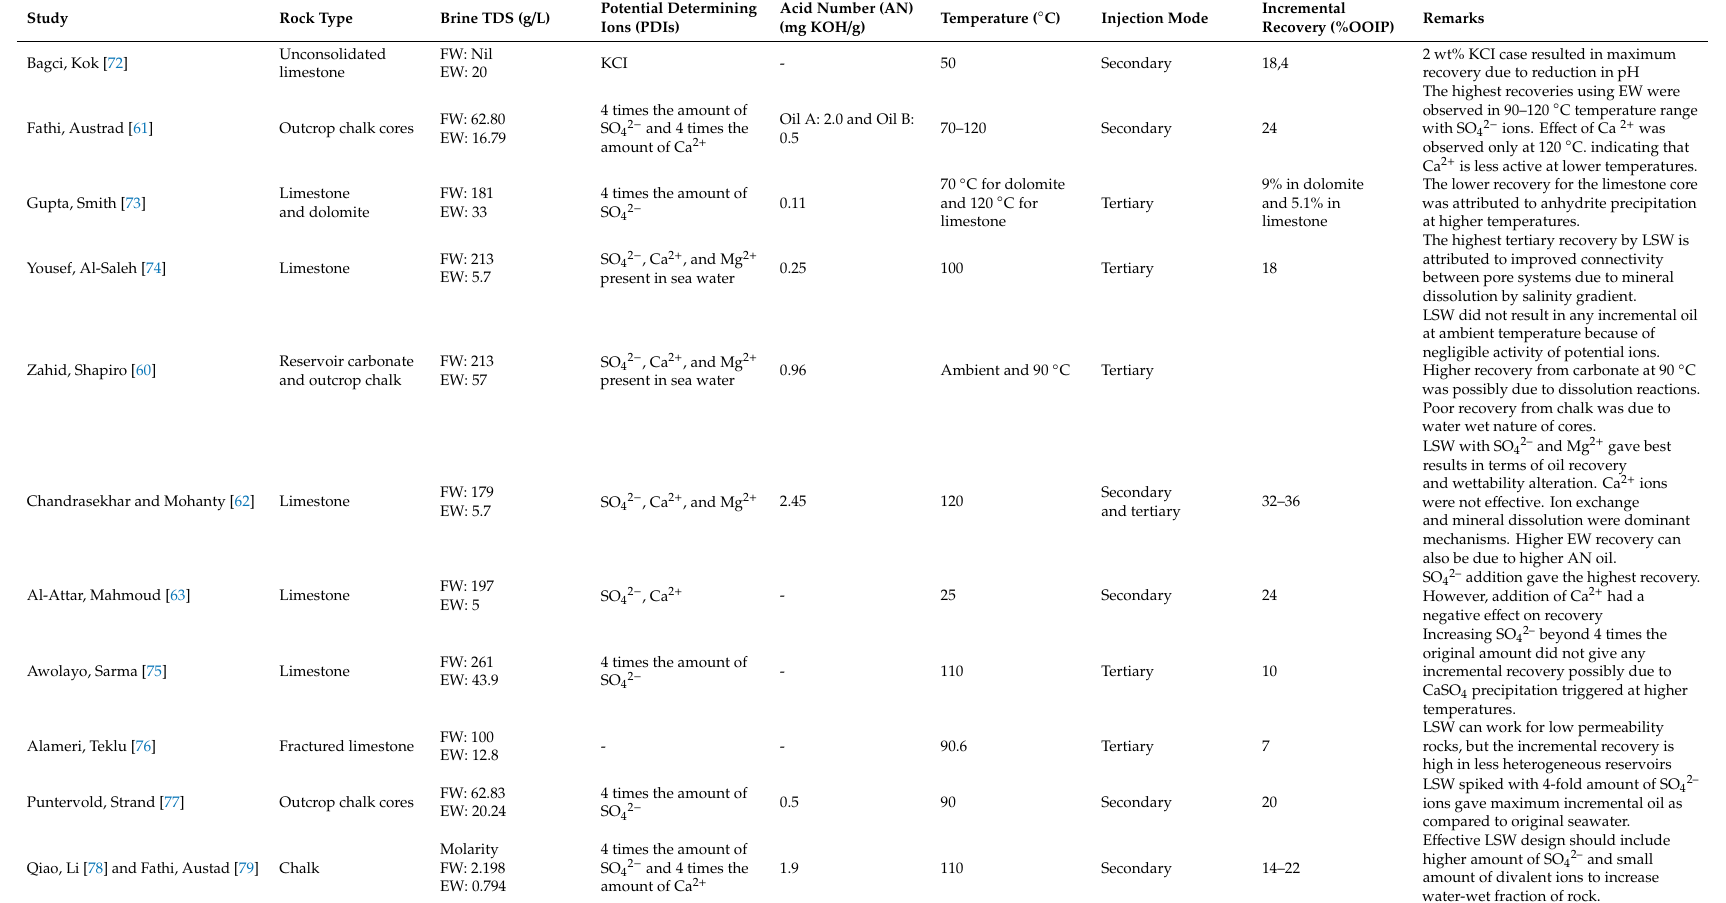
Table 1. Summary of corefloods where incremental oil recovery was achieved using engineered water flooding (EWF) in